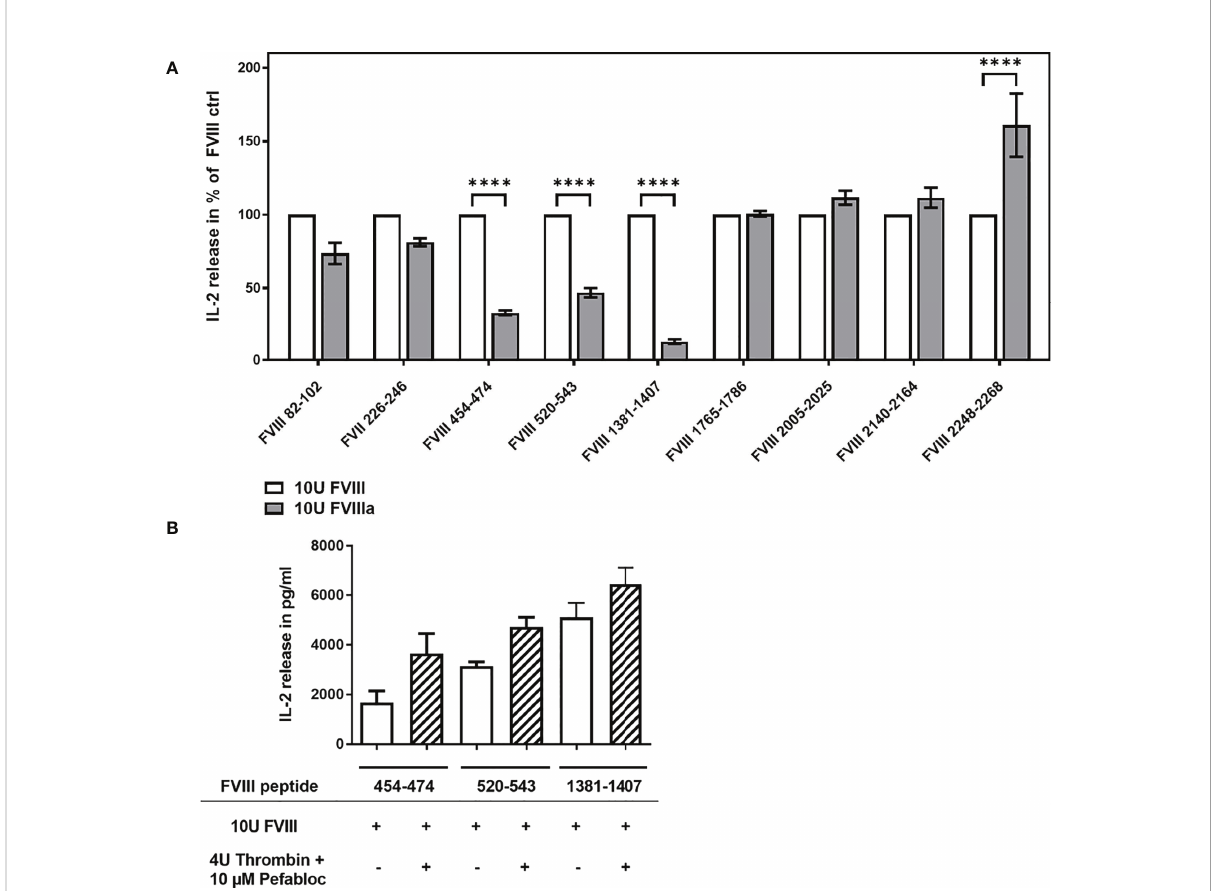
FIGURE 4 Differential activation of FVIII peptide-speci fi c CD4+ T cells hybridoma clones by FVIII and thrombin-activated FVIIIa, present during preincubation of APCs. FVIII speci fi c CD4+ T cell hybridoma clones were cocultured with APCs preincubated with either FVIII or thrombin- activated FVIIIa. (A) Relative IL-2 release by FVIII-speci fi c CD4+ T cell hybridoma clones speci fi c for the different FVIII peptide regions tested, comparing non-activated FVIII (100%) and thrombin-activated FVIIIa, present during the preincubation of APCs prior to subsequent co-culture with CD4+ T cell hybridoma clones. Depicted is the mean value ± SEM. Results were derived from 2 independent experiments done in triplicates (n=6). Statistical analysis for signi fi cance between different groups of measured mean IL-2 release was assessed by a two-way ANOVA with Sidaks ’ s multiple comparison test using Graphpad Prism 9 (GraphPad Software, Inc., California USA). P < 0.05 was considered statistically signi fi cant. *p<0.05; **p<0.01; ***p<0.001; ****p<0.0001; (B) Control experiment testing a potential in fl uence of Thrombin and Pefabloc, both used for the generation of activated FVIIIa, on APC function. APCs were preincubated with Thrombin and Pefabloc, and afterwards washed before adding FVIII. Subsequently, preincubated APCs were co-cultured with FVIII-speci fi c CD4+ T cell hybridoma clones speci fi c for the FVIII peptides